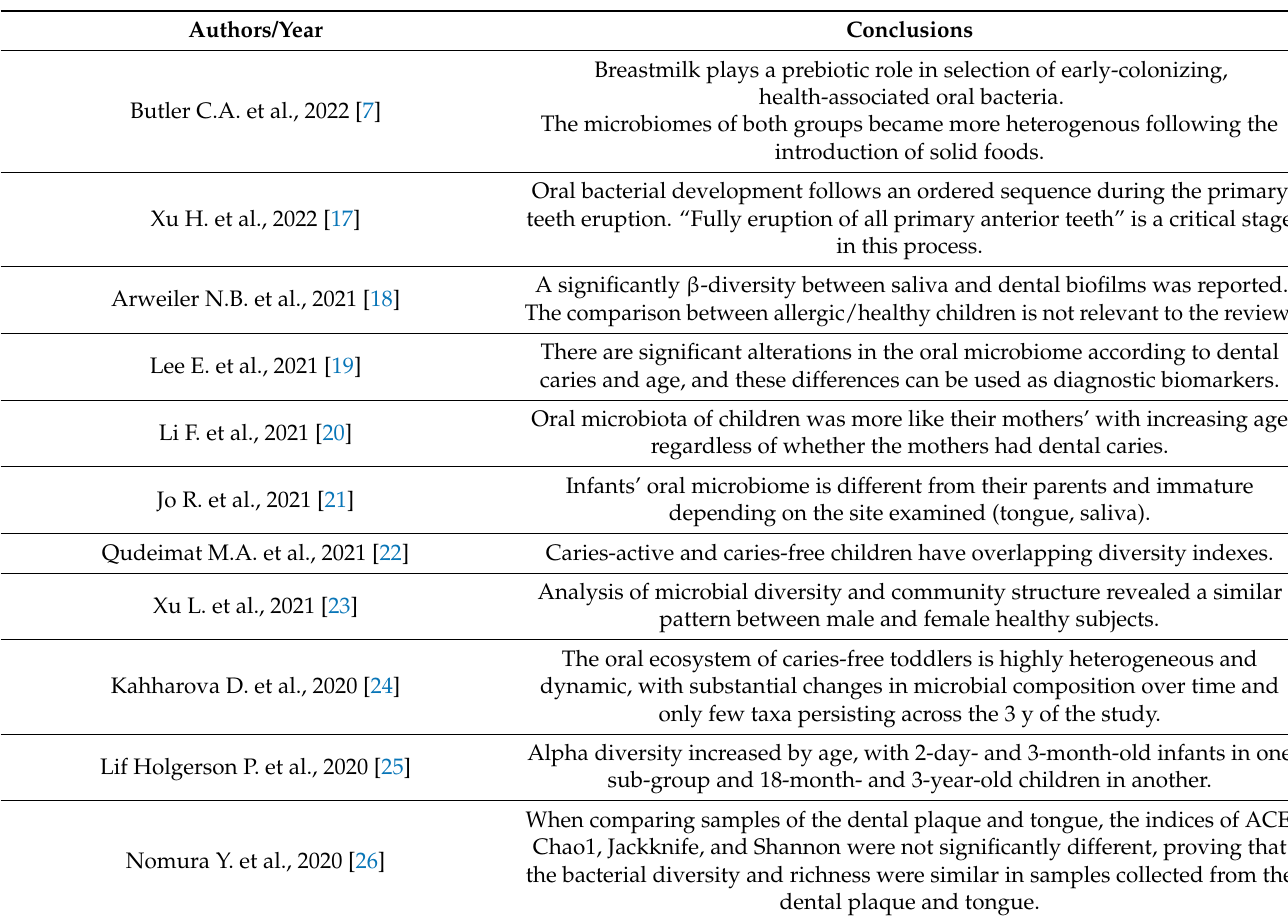
Table A2. Articles matching inclusion